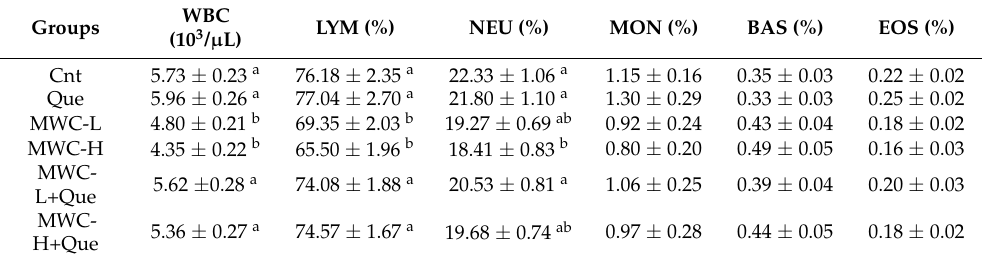
Table 3. Effect of MWCNTs and/or Que on total and differential WBCs count.